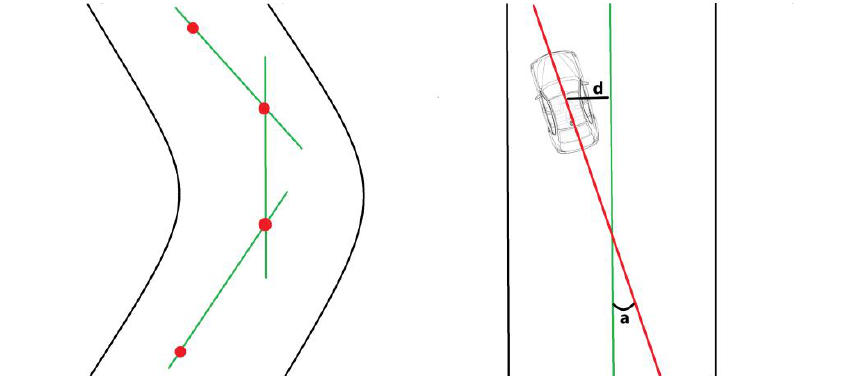
Figure 5. ( left ) Representation of local goals on the road. Each local goal is expressed as a point ( x , y , θ ) . With this information, we can generate a line (in green) with an orientation θ that crosses the point ( x , y ) (in red). ( right ) Error signal in distance d is obtained as the distance between the vehicle base link and the nearest point in the goal straight line (green). The error signal in angle a is obtained as the angle between the goal line (green) and the orientation vehicle line